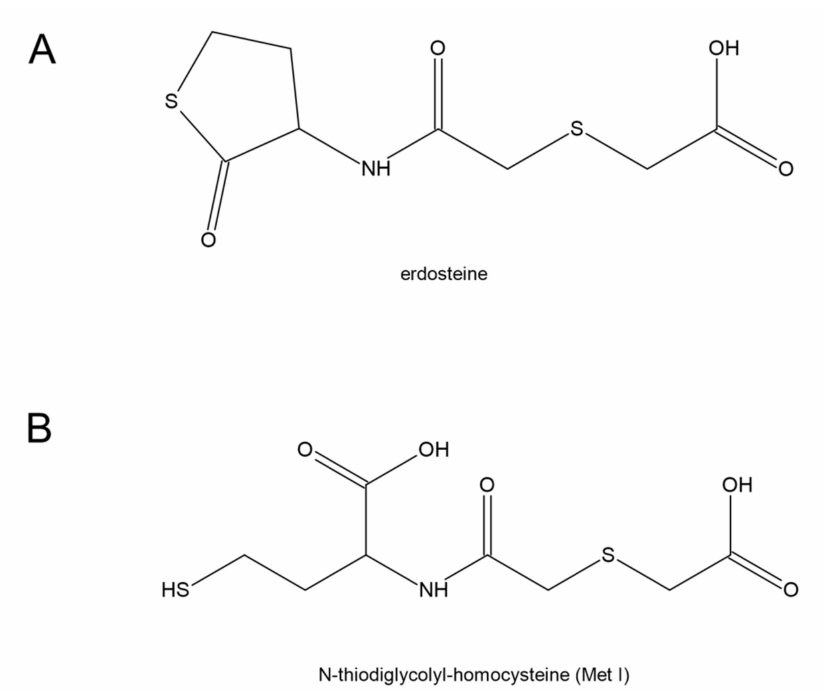
Figure 10. Structures of ( A ) erdosteine [N-(carboxymethylthioacetyl)-homocysteine thiolactone] and ( B ) its biologically active metabolite, N-thiodiglycolyl-homocysteine (Met